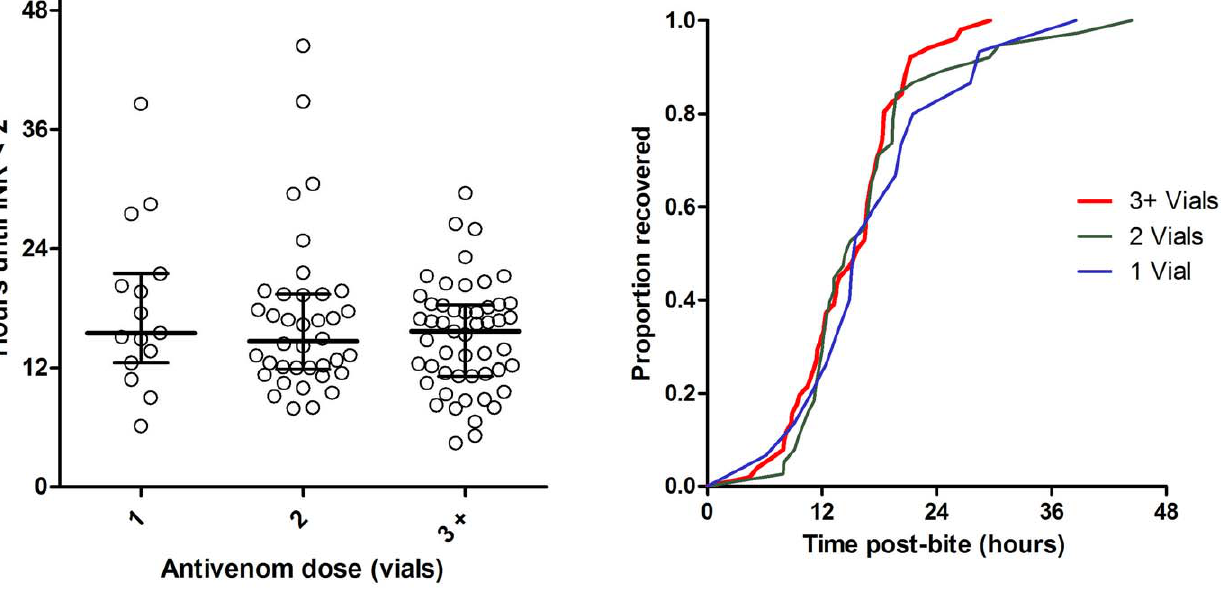
Figure 5. Time to recovery of VICC to an INR , 2 comparing patients receiving a total antivenom dose of one vial (N=15, blue line), two vials (N=38, green line), or three or more vials (N=51, red